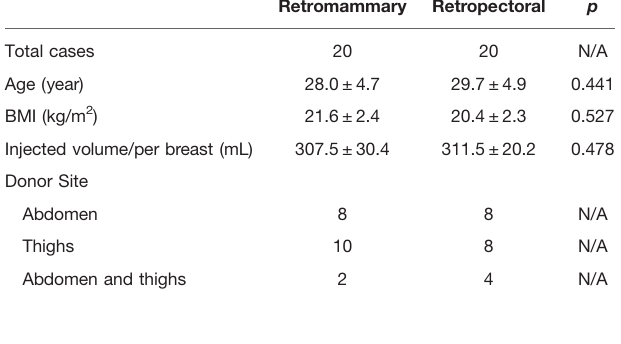
TABLE 1 | Summary of patient data.